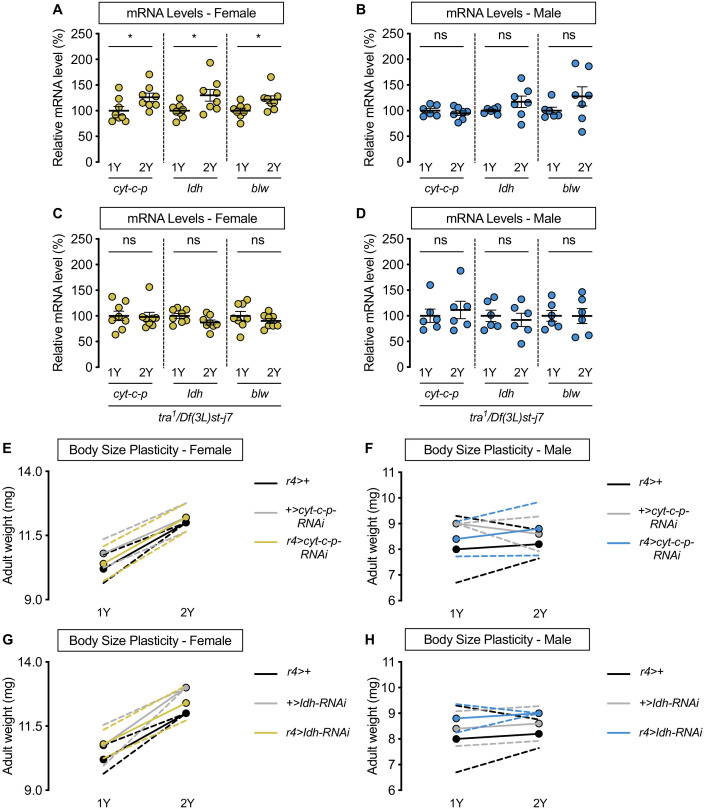
transformer (tra) is required for nutrient-dependent upregulation of spargel (srl) target expression in females, but not all srl targets are not required for increased female nutrient-dependent body size plasticity.(A) In control w1118 females, mRNA levels of the srl targets Cytochrome c proximal (cyt-c-p), Isocitrate dehydrogenase (Idh), and bellwether (blw) were significantly higher in larvae raised on a protein-rich diet (2Y) compared with larvae raised on a diet containing half the protein (1Y) (p=0.0409, 0.0307, and 0.0274, respectively; Student’s t test). n = 8 biological replicates. (B) In control w1118 males, mRNA levels of cyt-c-p, Idh, and blw were not significantly different in larvae raised on 2Y compared with larvae raised on 1Y (p=0.4316, 0.1906, and 0.2146, respectively; Student’s t test). n = 6–7 biological replicates. (C) In tra mutant females, mRNA levels of cyt-c-p, Idh, and blw were not significantly different in larvae raised on 2Y compared with larvae raised on 1Y (p=0.8865, 0.0731, and 0.334, respectively; Student’s t test). n = 8 biological replicates. (D) In tra mutant males, mRNA levels of cyt-c-p, Idh, and blw were not significantly different in larvae raised on 2Y compared with larvae raised on 1Y (p=0.6078, 0.6453, and 0.9819, respectively; Student’s t test). n = 6 biological replicates. (E) Adult weight was significantly higher in r4>+, +>cyt-c-p-RNAi, and r4>cyt-c-p-RNAi females reared on 2Y compared with genotype-matched females cultured on 1Y (p<0.0001 [r4>+], p=0.0004 [+>cyt-c-p-RNAi], and p<0.0001 [r4>cyt-c-p-RNAi], respectively; two-way ANOVA followed by Tukey HSD test). The magnitude of the nutrient-dependent increase in adult weight was not significantly different (genotype:diet interaction p=0.4936; two-way ANOVA followed by Tukey HSD test). n = 5 groups of 10 flies. (F) Adult weight was not significantly different in r4>+, +>cyt-c-p-RNAi, and r4>cyt-c-p-RNAi males reared on 2Y compared with genotype-matched males cultured on 1Y (p=0.9954 [r4>+], p=0.8873 [+>cyt-c-p-RNAi], and p=0.8873 [r4>cyt-c-p-RNAi], respectively; two-way ANOVA followed by Tukey HSD test). n = 4–5 groups of 10 flies. (G) Adult weight was significantly higher in r4>+, +>Idh-RNAi, and r4>Idh-RNAi females reared on 2Y compared with genotype-matched females cultured on 1Y (p<0.0001 for all comparisons; two-way ANOVA followed by Tukey HSD test). The magnitude of the nutrient-dependent increase in adult weight was not significantly different (genotype:diet interaction p=0.2104; two-way ANOVA followed by Tukey HSD test). n = 4–5 groups of 10 flies. (H) Adult weight was not significantly different in r4>+, +>Idh-RNAi, and r4>Idh-RNAi males reared on 2Y compared with genotype-matched males cultured on 1Y (p=0.9912 [r4>+], p=0.9885 [+>Idh-RNAi], and p=0.9885 [r4>Idh-RNAi], respectively; two-way ANOVA followed by Tukey HSD test). n = 4–5 groups of 10 flies. For body size plasticity graphs, filled circles indicate mean adult weight, and dashed lines indicate 95% confidence interval. * indicates p<0.05; ns indicates not significant; error bars indicate SEM.